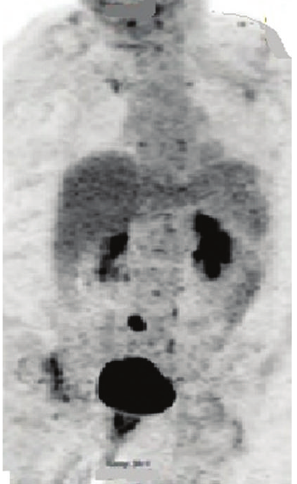
Figure 4: PET CT scan with avid FDG uptake associated with the sigmoid